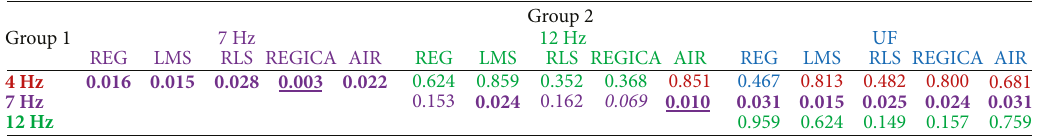
Figure 7: Statistical increases between classi fi cation accuracies after artifact corrections with di ff erent EOG fi ltering (paired t -tests were used between group 1 versus group 2). Bold and underline: p < 0 01 ; Bold: p < 0 05 ; Italic: p < 0 1 ; Color indicate better